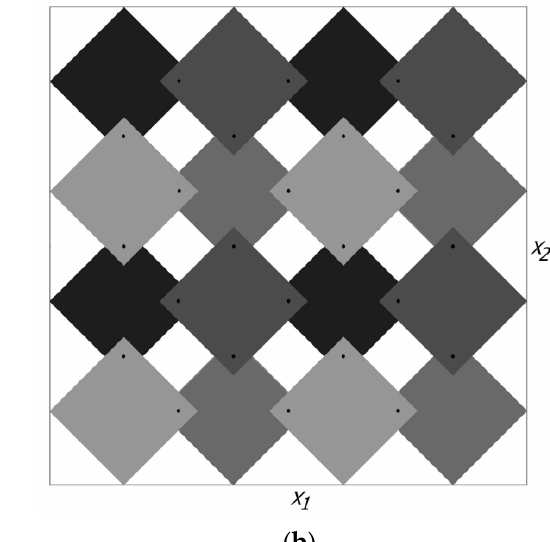
( c ) Figure 6. Auxetic structure 2 × 2 in partially open ( a ) and open positions ( b ) for x = 0.11, 𝜃 2 =7.2° (according to the Equation (2)) together with the structure for x = 0.25 ( c ). Figure 7 demonstrates the relationship for the change in pore surface in a 2 × 2 struc- ture (for a = 25 mm). It shows that, with the increase of the parameter x — the shift of the axis of rotation to the center of the square — the surface area of the pores decreases very